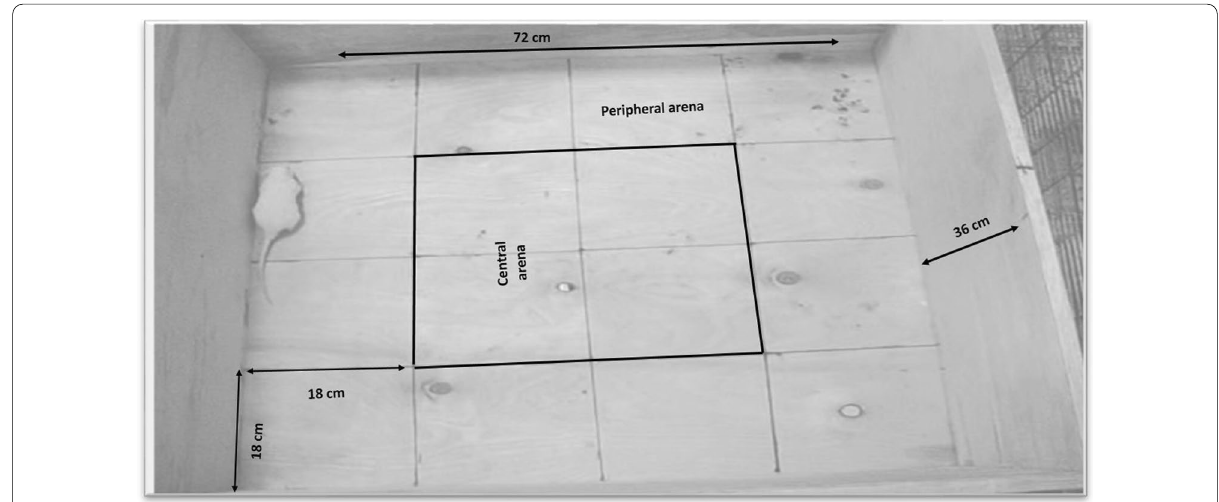
Fig. 1 Open field test apparatus